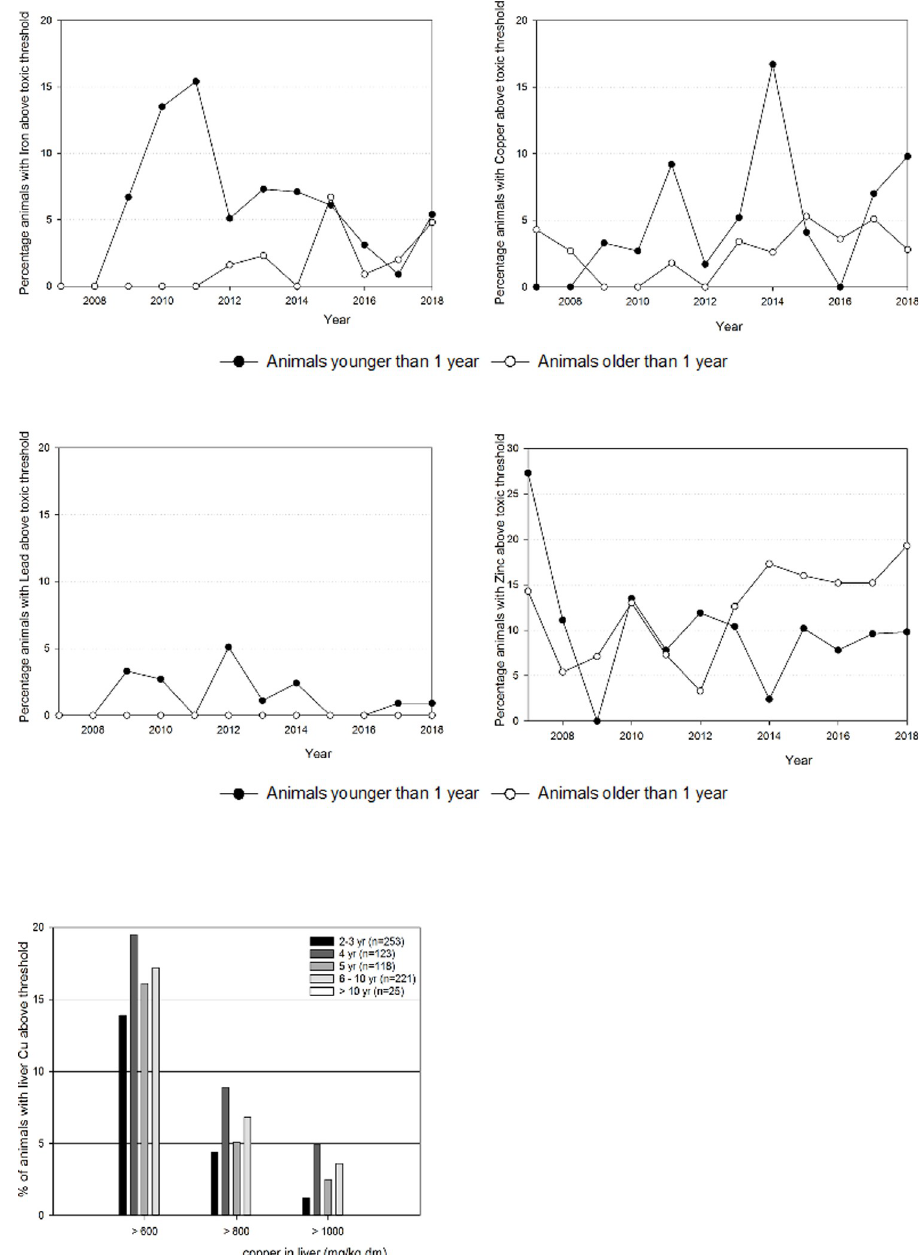
Fig 3. Percentage of animals (young versus older animals) with copper, zinc or iron, and numbers of animals for lead, above the toxic thresholds for young and older animals. Fig 3A Copper, Fig 3B Zinc, Fig 3C Iron, Fig 3D Lead, Fig 3E Animals at different age with copper above a certain threshold